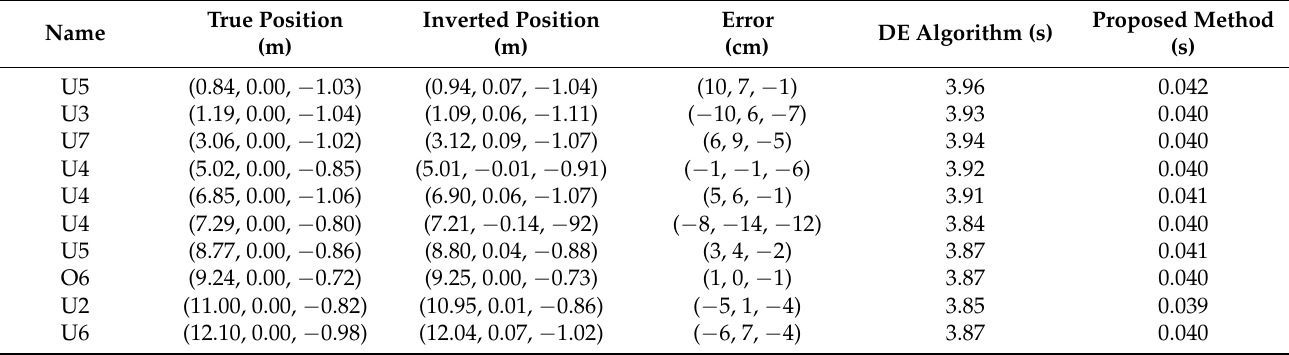
Table 5. Localization results of